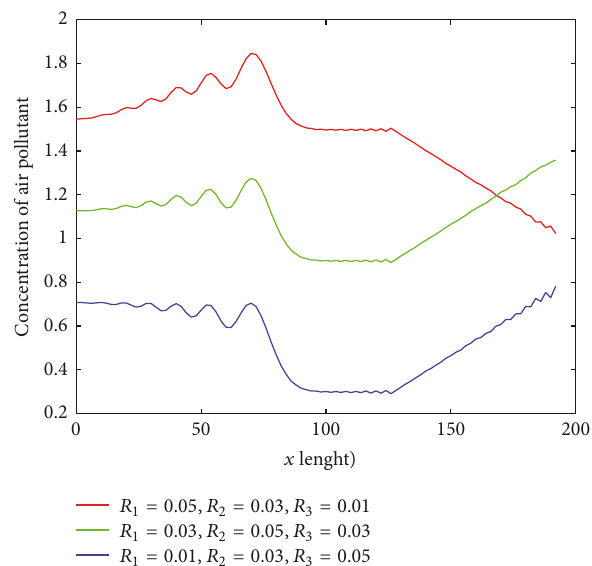
Figure 18: Surface plot of concentration of air pollutant levels for 𝑅 = 0.01, 𝑅 = 0.03 , and 𝑅 = 0.05 sec −1 . 1 2 3